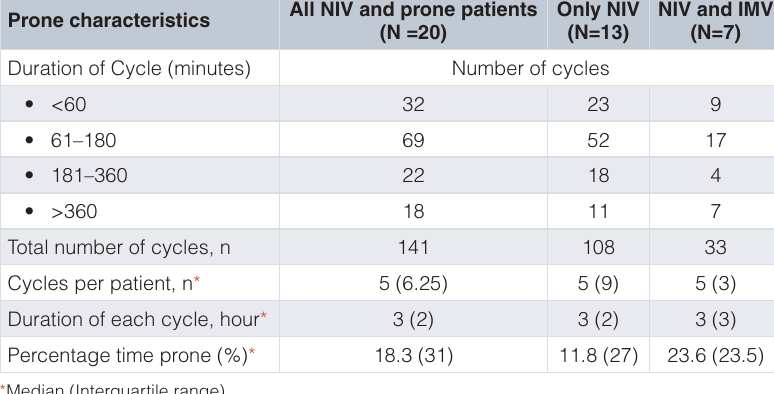
Table 2. Prone cycle characteristics for all